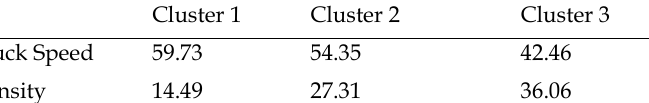
Figure 7. Case study II three clusters speed-density plot Table 10. Case study II cluster centers of three clusters